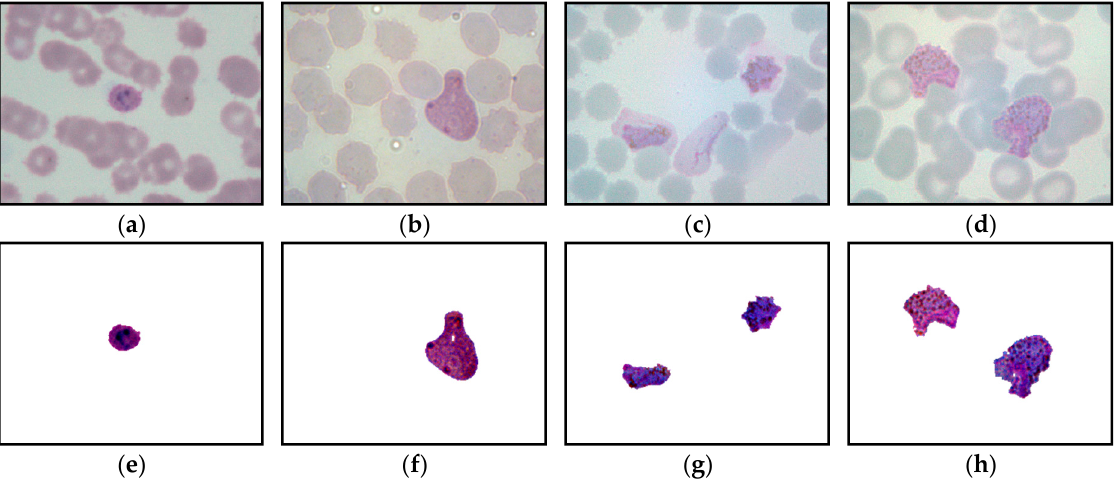
Figure 9. Original and final segmented images for P. vivax : ( a ) Original ring; ( b ) Original trophozo- ite; ( c ) Original schizont; ( d ) Original gametocyte; ( e ) Segmented ring ( f ) Segmented trophozoite; ( g ) Segmented schizont; ( h ) Segmented gametocyte.